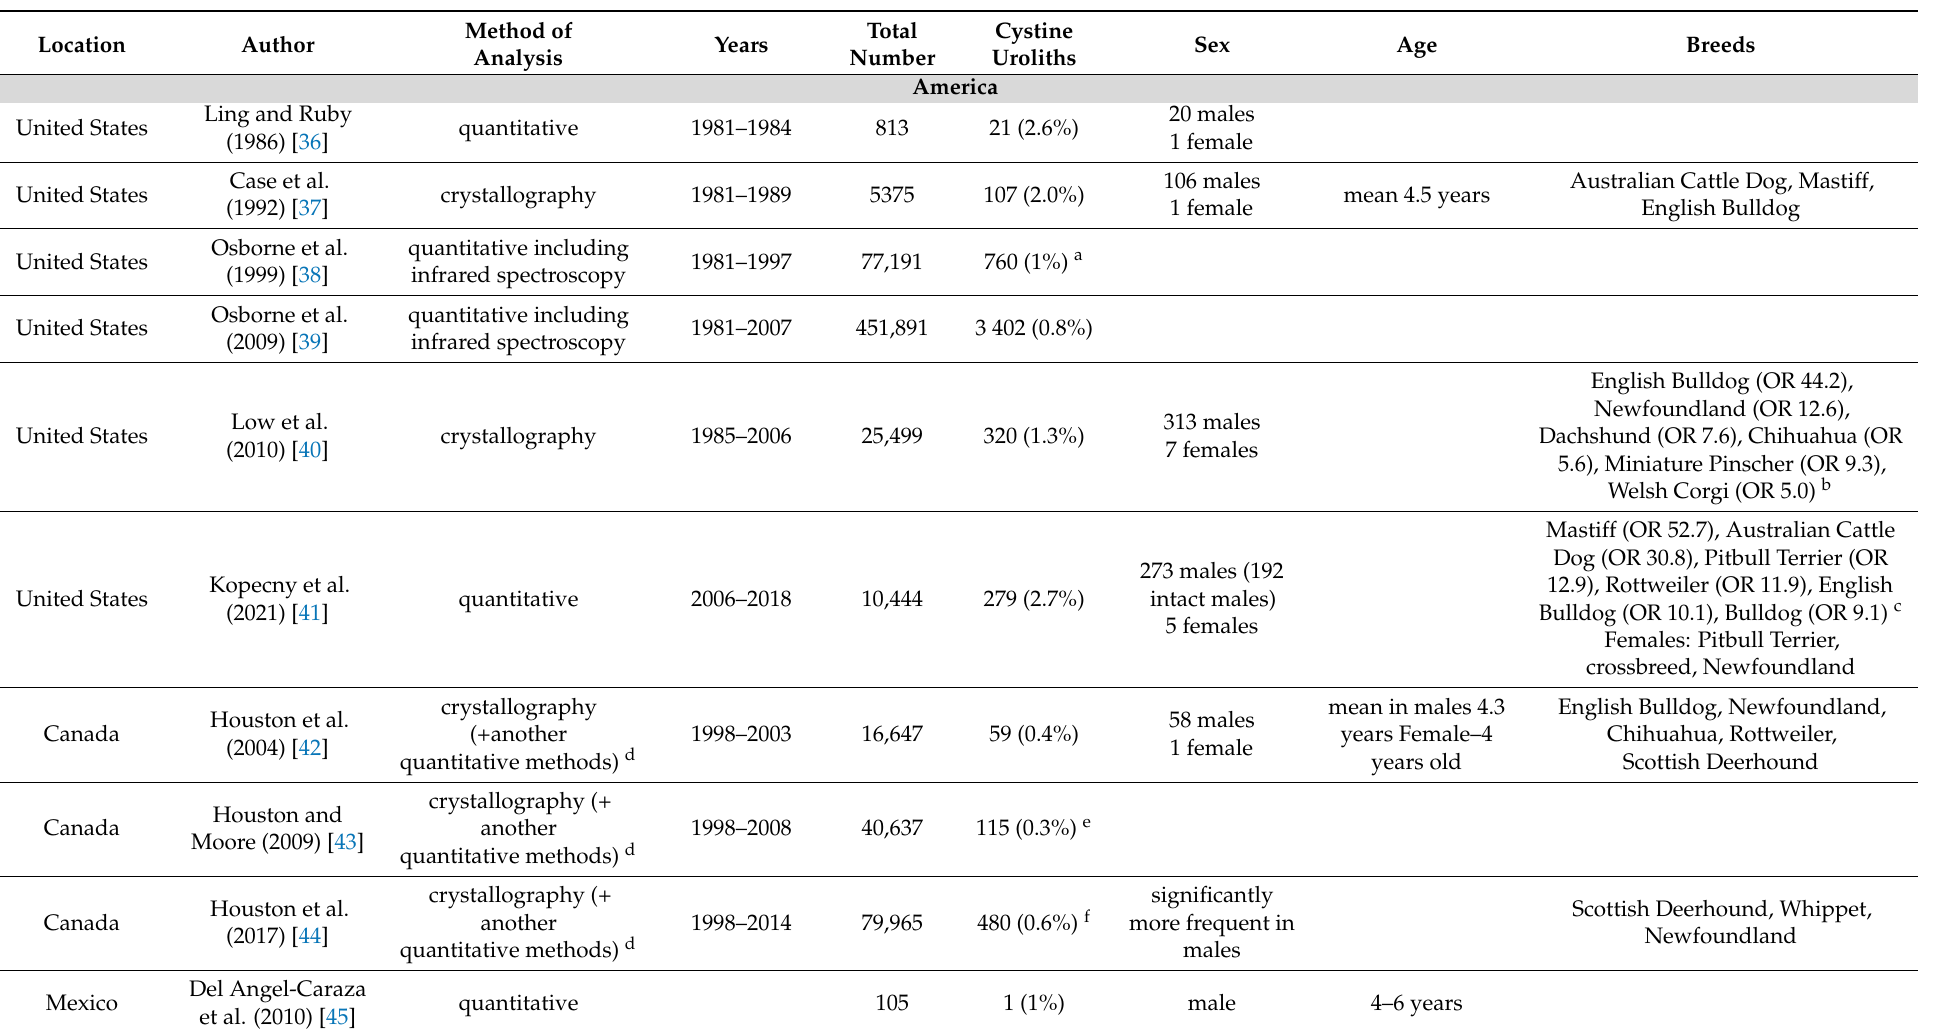
Table 2. Prevalence of cystine urolithiasis in dogs by region and characteristics of affected dogs in various